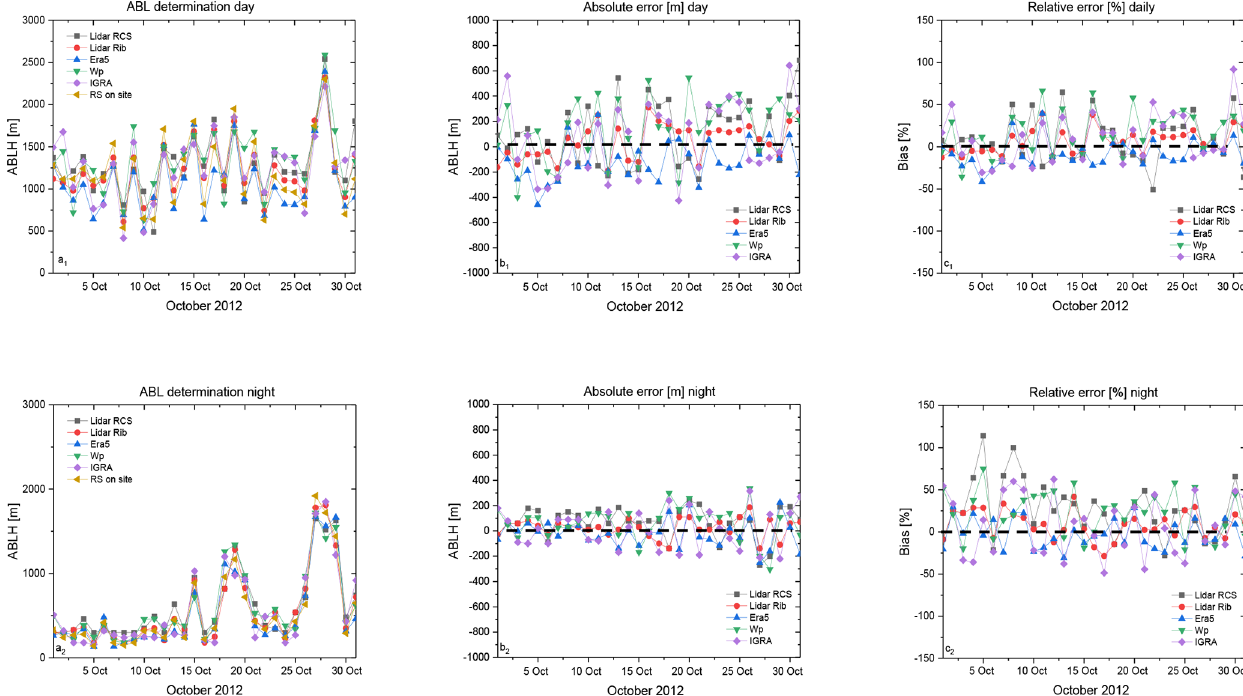
Figure 2. Time evolution over the time period 1–31 October 2012 of the six distinct ABLH estimates illustrated in the paper. Panel (a1) illustrates the daytime comparison, while panel (a2) illustrates the night-time comparison. “Lidar Ri b ” stands for ABLH estimates obtained through the Richardson number method applied to the Raman lidar data, “RS on-site” stands for ABLH estimates obtained through the Richardson number method applied to the on-site radiosonde data, “IGRA” stands for ABLH estimates obtained through the Richardson number method applied to the IGRA radiosonde data, “ERA5” stands for ABLH estimates obtained through the Richardson number method applied to the ECMWF-ERA5 analysis data, “WP” stands for ABLH estimates obtained from wind profiler, and “Lidar RCS” stands for ABLH estimates obtained from range-corrected elastic backscatter lidar signals. Panels (b1) – (b2) and (c1) – (c2) represent the daytime de- viations, expressed both in metres and in percentage (%), between the ABLH estimate obtained through the application of the Richardson number approach to the on-site radiosonde profiles and the five remaining ABLH estimates. Panels (b1) and (c1) illustrate the daytime comparison, while panels (b2) and (c2) illustrate the night-time